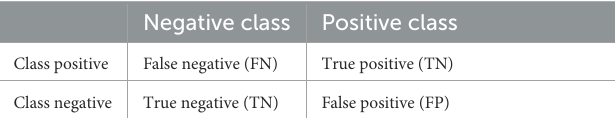
TABLE 8 Confusion matrix.